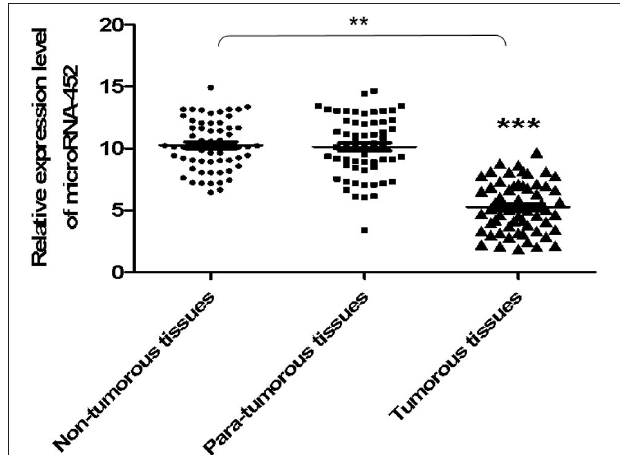
FIGURE 7 | The expression level of miR-452 in tissues of TNBC. The expression level of miR-452 in non-tumorous, para-tumorous, and tumorous tissues of patients with TNBC were detected. The result showed that the relative expression level of miR-452 in tumor was remarkably lower than that of para-tumorous and non-tumorous tissues. However, there was no significant difference between non-tumorous and para-tumorous tissues. ** P < 0.01, *** P <